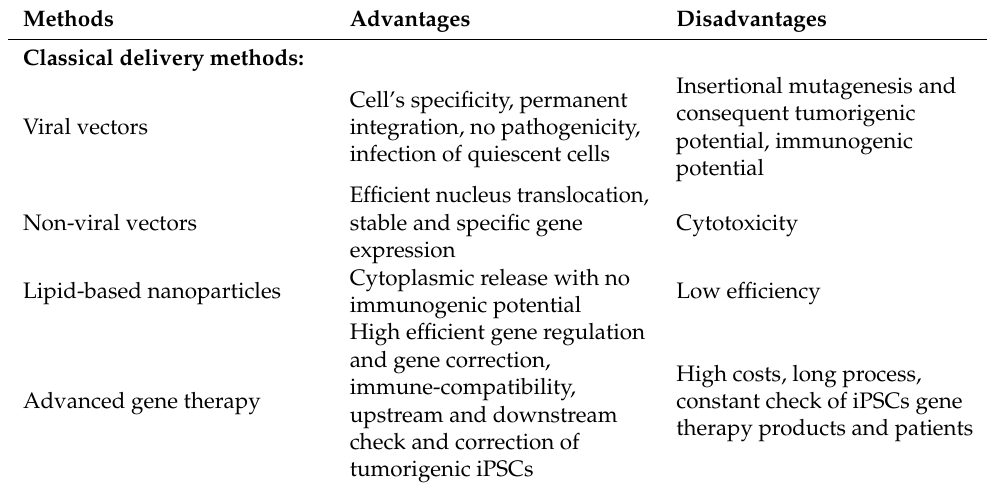
Table 1. Advantages and disadvantages of classical and advanced gene therapy delivery